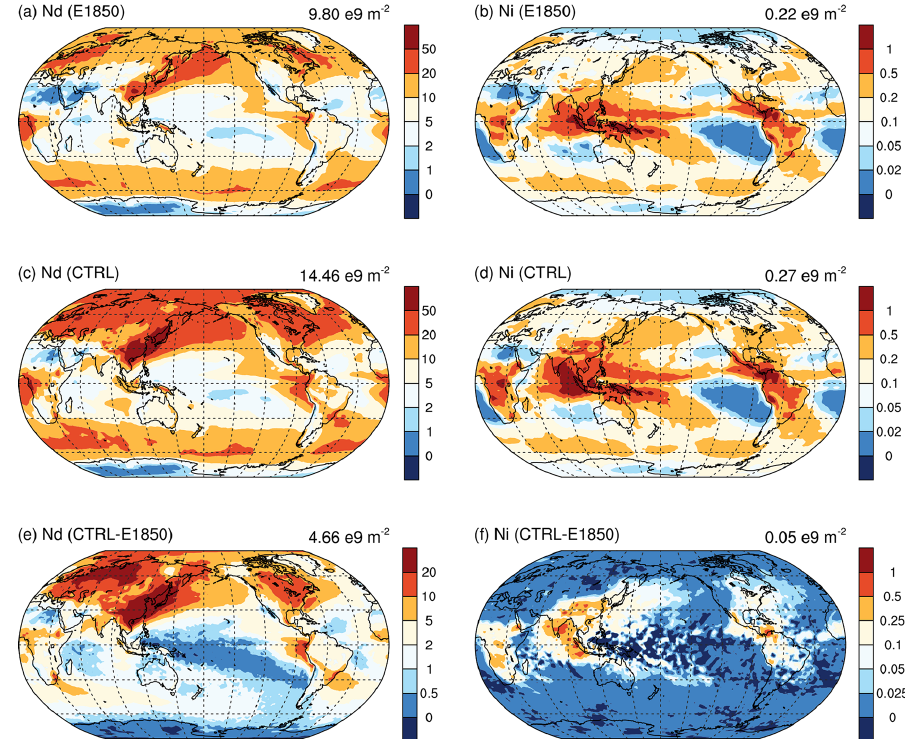
Figure 12. Annual mean column-integrated cloud droplet and ice crystal number concentrations for the pre-industrial era (E1850, panels a, b ), present day (CTRL for year 2010, panels c, d ), and PD–PI differences (e, f) in the nudged simulations. See Sect. 4.4 for